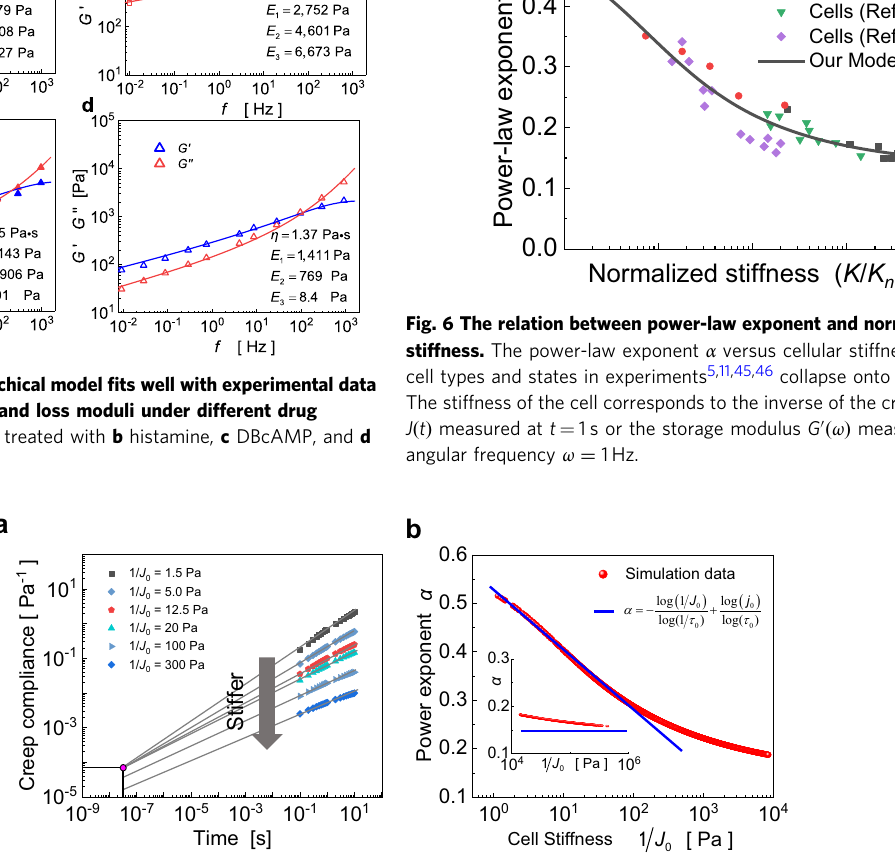
. Inset shows the power- 0